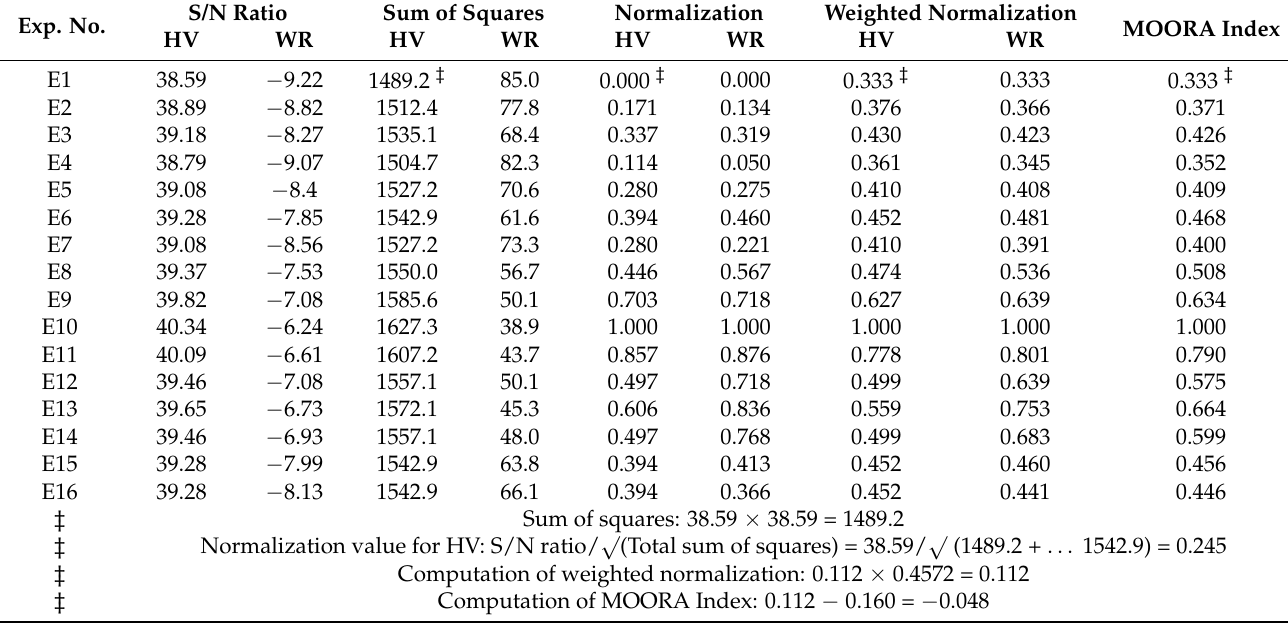
Table 11. Taguchi-CRITIC-MOORA based multiple objective optimization.